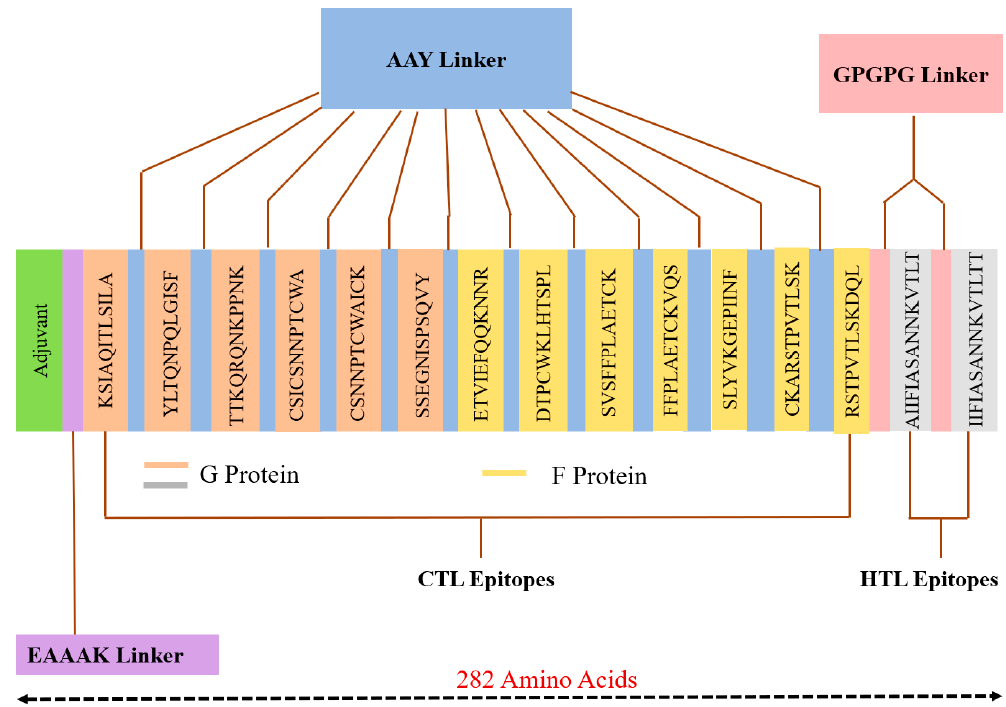
Figure 4. MEV construct overview. It has 282 amino acids, consisting of an adjuvant (green) linked at N-terminal of MEV with the help of EAAAK linker (purple). AAY linker (blue) used to join the CTL epitopes and GPGPG linker (pink) was used to join the HTL epitopes.